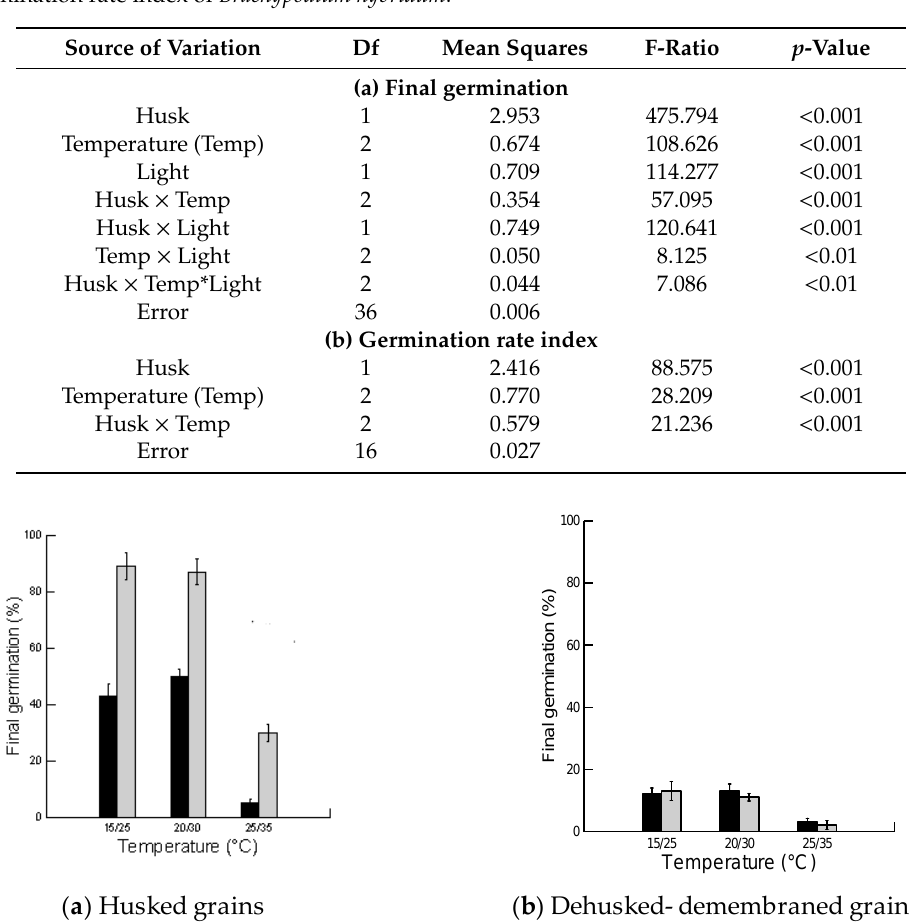
Table 2. Results of ANOVA showing the e ff ects of husk treatment as well as light and temperature of the grain incubation on final germination, and the e ff ect of husk treatment and temperature on the germination rate index of Brachypodium hybridum .